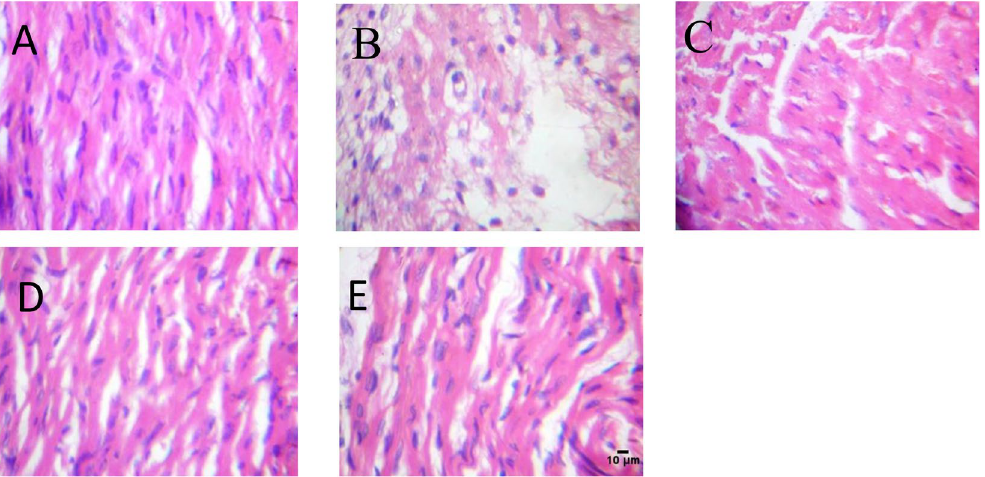
Figure 3. Histopathological changes of myocardial tissue (H&E); magnification × 400. ( A ) Control; ( B ) ISO alone; ( C ) ISO and metoprolol ( D ) ISO and CurNisNp (10 mg/kg) ( E ) ISO and CurNisNp (21 mg/kg). Group B showed myocardial cells necrosis, separation of cardiac myofibrillar and inflammatory cells infiltration due to ISO which were significantly reduced by pretreatment of metoprolol and CurNisNp respectively (Groups C–E).